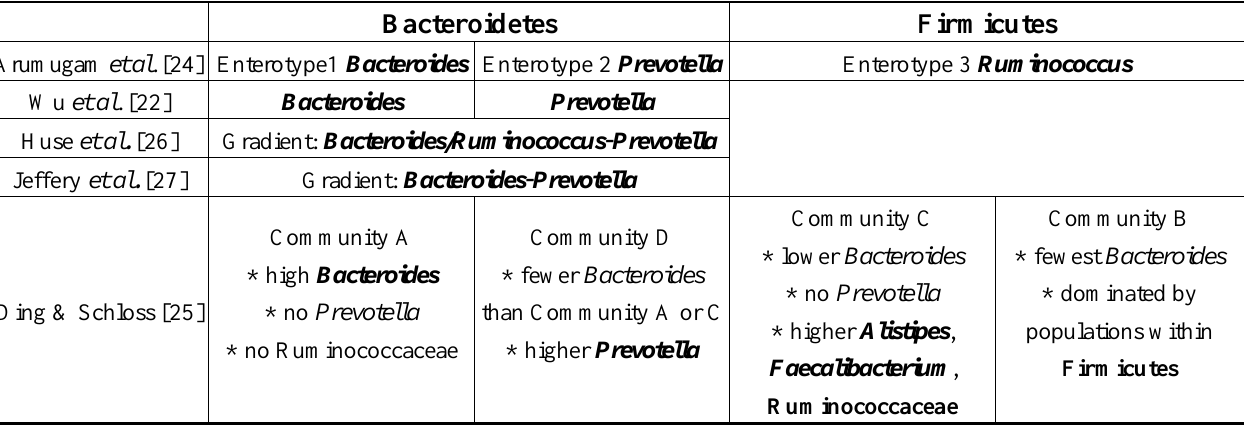
Table 1. Fecal microbiota community types based upon predominant